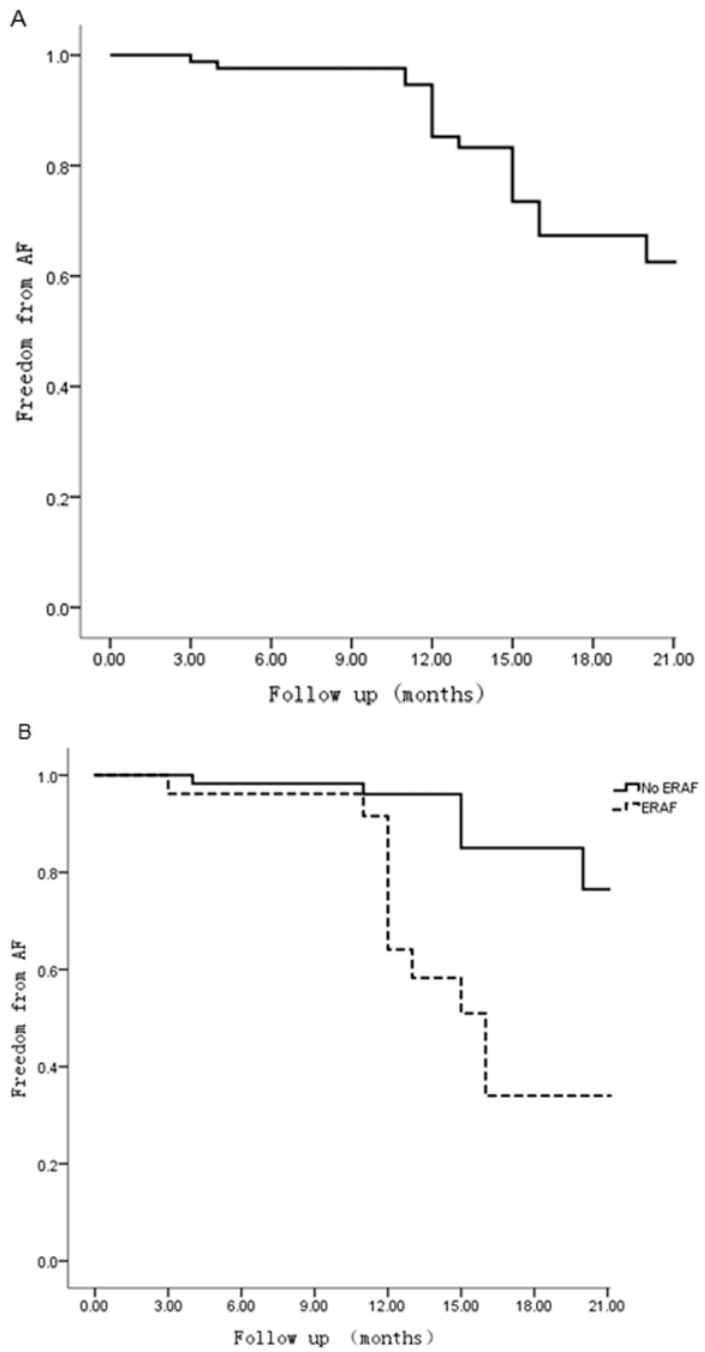
Fig 2. Kaplan-Meier Curves estimates of patients freedom from AF after BRAF. (A) Freedom from AF after BRFA in overall patients. (B) Freedom from AF after BRAF in patients with and without late AF recurrence (Log rank p test = 0.000). AF: atrial fibrillation; BRFA: bipolar radiofrequency ablation; LRAD: late recurrence of AF.